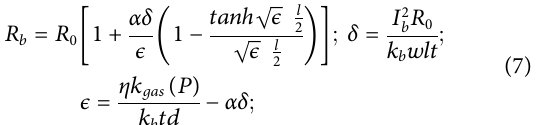
Frontiers in Mechanical Engineering |